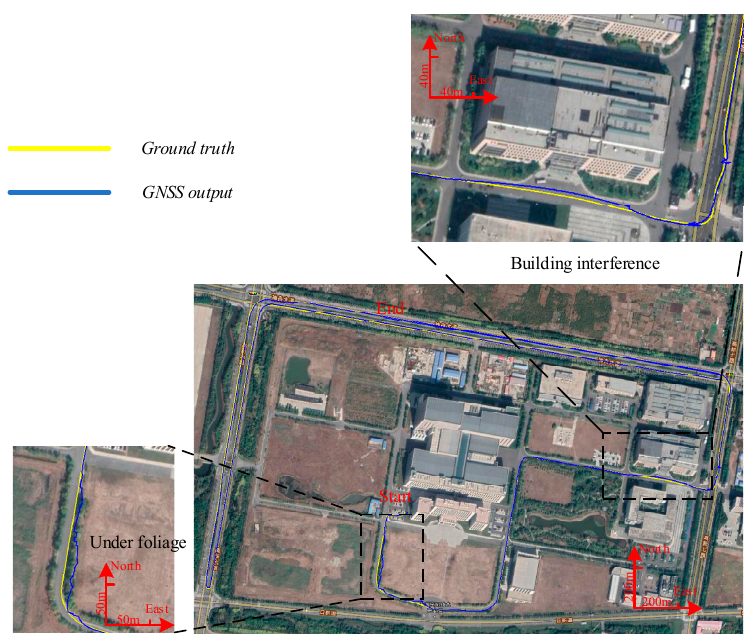
Figure 3. Ground trajectory of the field experiment.